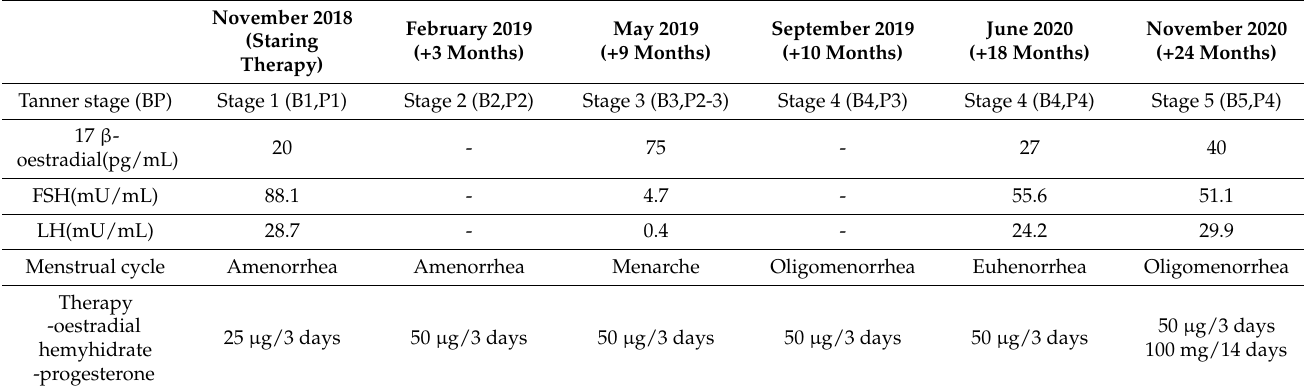
Figure 1. Magnetic resonance before and after estrogen replacement therapy. Panels “ a ”,“ b ” show uterine hypoplasia (continuous white arrows) in sagittal (panel “ a ”) and transversal plane (panel “ b ”). Reduced uterine thickness, consistent with pre-pubertal morphology, is evidenced in panel “ a ” (dashed arrow). In panels “ c ”,“ d ”, continuous white arrows indicate the uterine development after 24 months of estrogen therapy both in sagittal (panel “ c ”) and transversal (panel “ d ”) planes. Endometrial development and increase in uterine thickness are evident in panel “ c ” (dashed arrow). Table 1. Hormonal and clinical changes over time of the described clinical case. B: breast; P: pubic hair; FSH: Follicular- Stimulating Hormone; LH: Luteinising